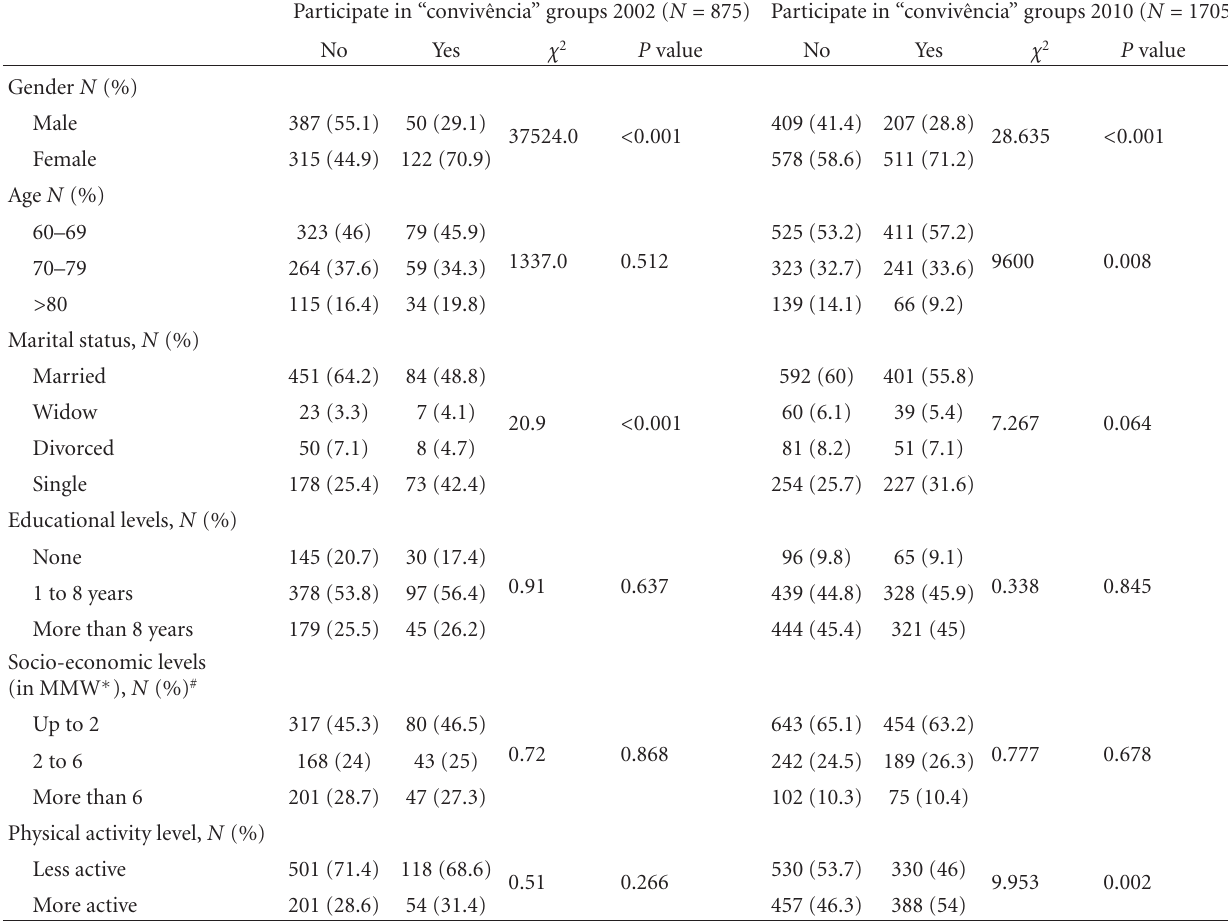
Table 2: Participation of the older adults in “convivˆencia groups”, 2002 and 2010 in Florian´opolis,